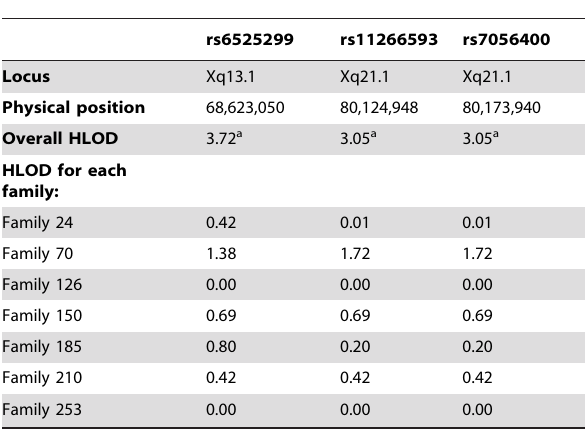
Table 2. SNPs with highest HLOD scores in parametric linkage analysis of spontaneous preterm birth with the affected fetus